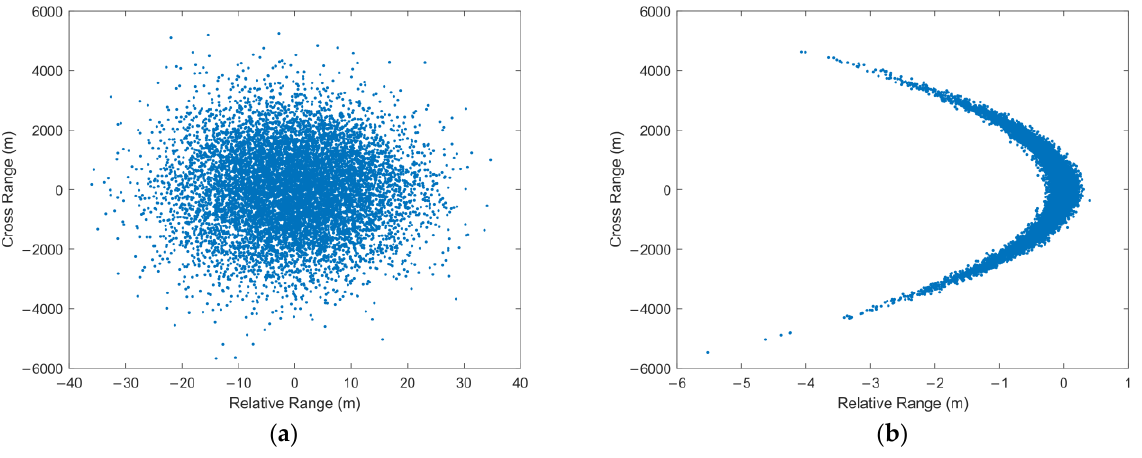
Figure 7. Measurements Distribution: ( a ) Measurements Distribution: ( a ) β = 3.7, CL ( x ;2700 km, ( 10 m ) 2 , ( 0.3 ◦ ) 2 ) and